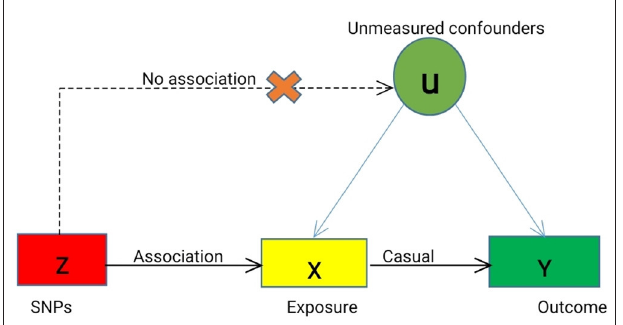
FIGURE 1 | Mendelian Randomization Model. We conducted MR analyses based on the following assumptions, (a) the instrumental variables (IVs) for each of the Hcy level (exposure) are associated with the risk of MPDs (outcome), (b) the IVs are not associated with any confounders (U), and (c) the IVs are associated with MPDs only through Hcy level, not through other causal pathway. Solid lines are theorized to exist; dashed lines are theorized to be non-significant according to MR assumptions. Causal directed acyclic graph illustrating the instrumental variable assumptions for the instrumental variable, exposure X, outcome Y, and the set of variables (U) that confound the association between X and